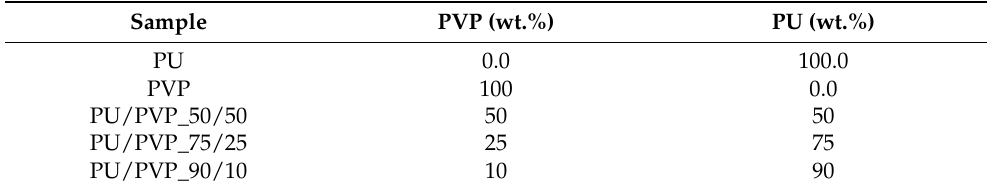
Table 1. Sample names for different hybrid films and their respective PVP and PU contents on dry basis. Sample PVP (wt.%) PU